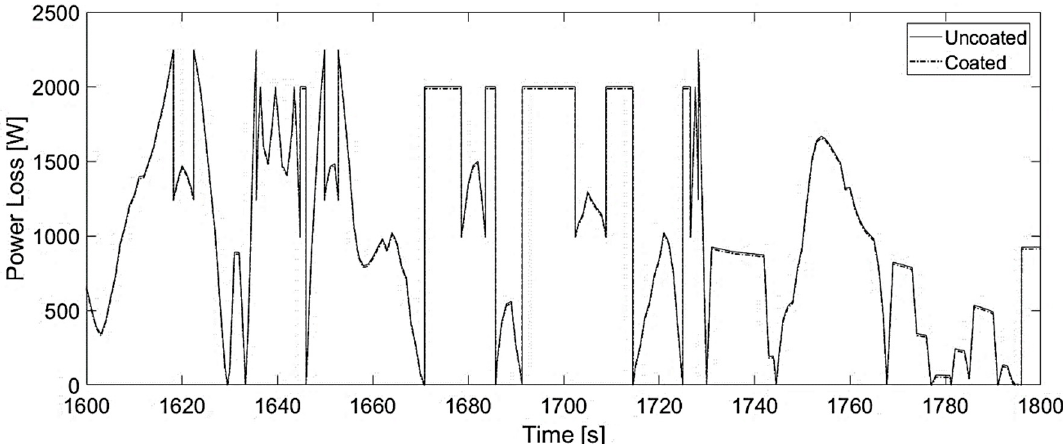
Figure 16. Power losses for uncoated and coated gears, RDE cycle part.